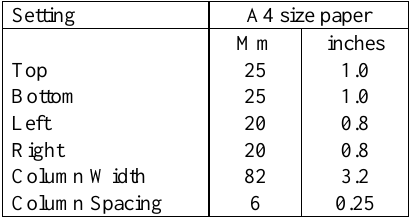
Table 1. Margin settings for A4 size paper